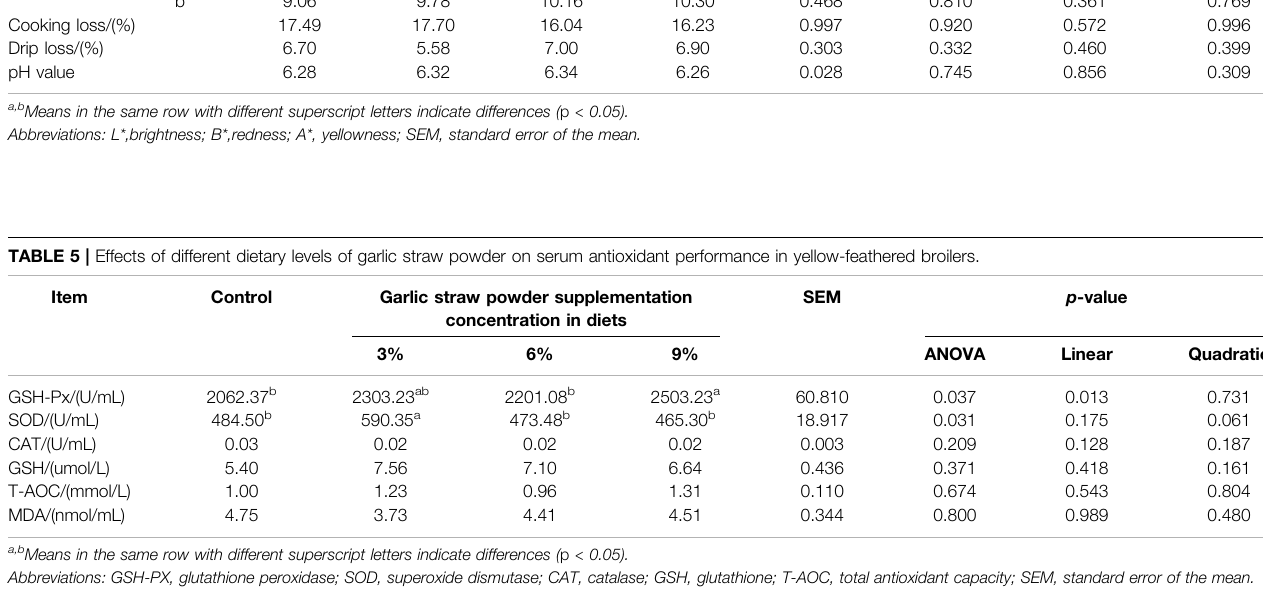
TABLE 6 | Effects of different dietary levels of garlic straw powder on intestinal morphology in yellow-feathered broilers. Item Control Garlic straw powder